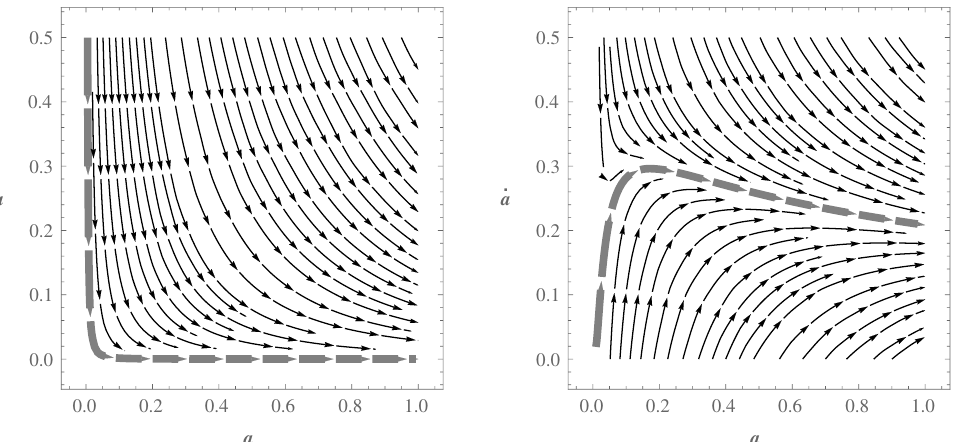
Figure 7. Phase space portrait for Equation (32). The left and right panels are associated with the commutative case ( θ = 0) and noncommutative case ( θ = − 0.0003), respectively. We have also assumed n = 6, W = 5, 8 π G = 1, a i = 0.005 and φ i = 0.01 for both of the